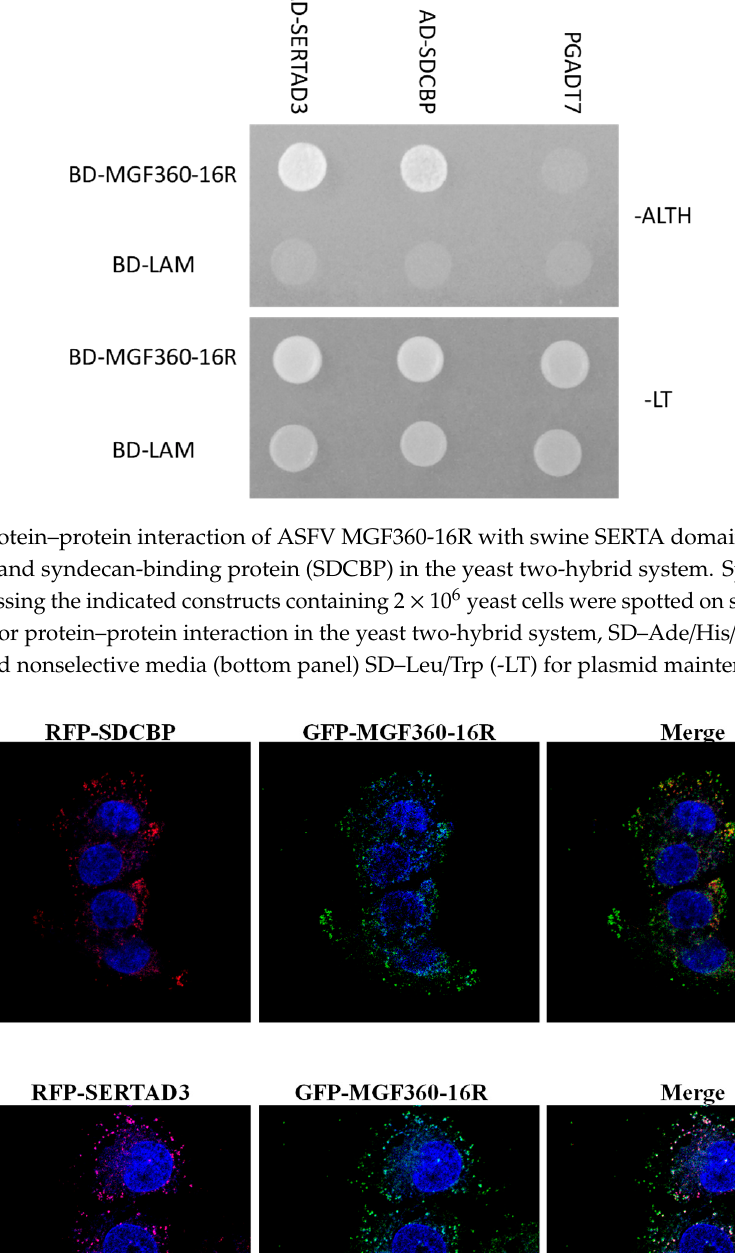
Figure 5. Protein–protein interaction of ASFV MGF360-16R protein with swine SERTAD3 and SDCBP in eukaryotic cells. Colocalization of MGF360-16R and either ( A ) SERTAD3 or ( B ) SDCBP in swine kidney (SK6) cells imaged at 1000×. GFP-MGF360-16R-GFP and RFP-SERTAD3 or RFP-SDCBP constructs were co-transfected in SK6 cell cultures as indicated. Yellow color in the merged panel indicates the presence of co-localization between RFP and GFP.